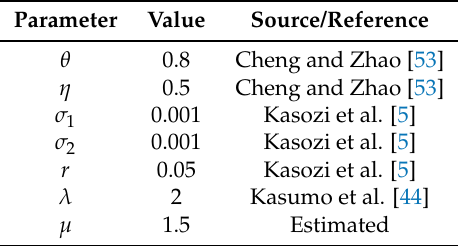
Table 1. Model parameter